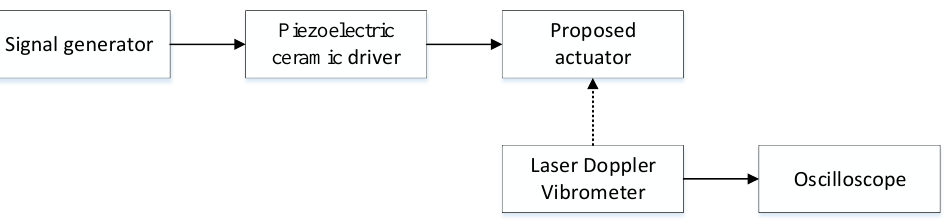
Figure 6. Characteristic test system schematic diagram of the proposed device.